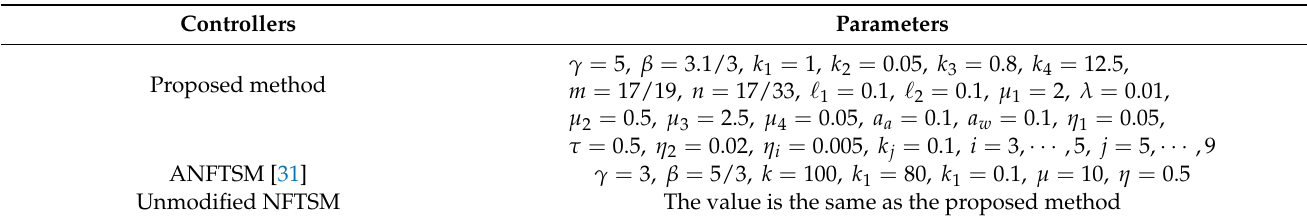
Table 1. Controller parameters